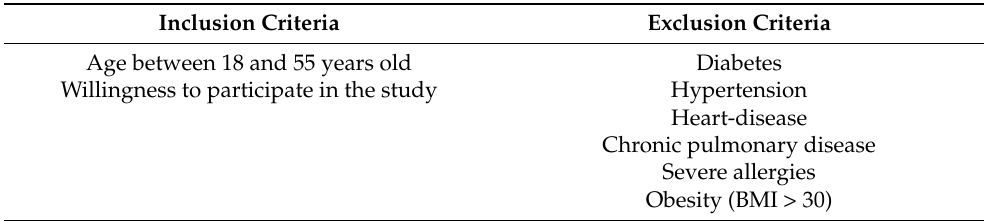
Table 2. The inclusion and exclusion criteria of HD and RD groups of BNT162b2 vaccinated people under 55 years of age.